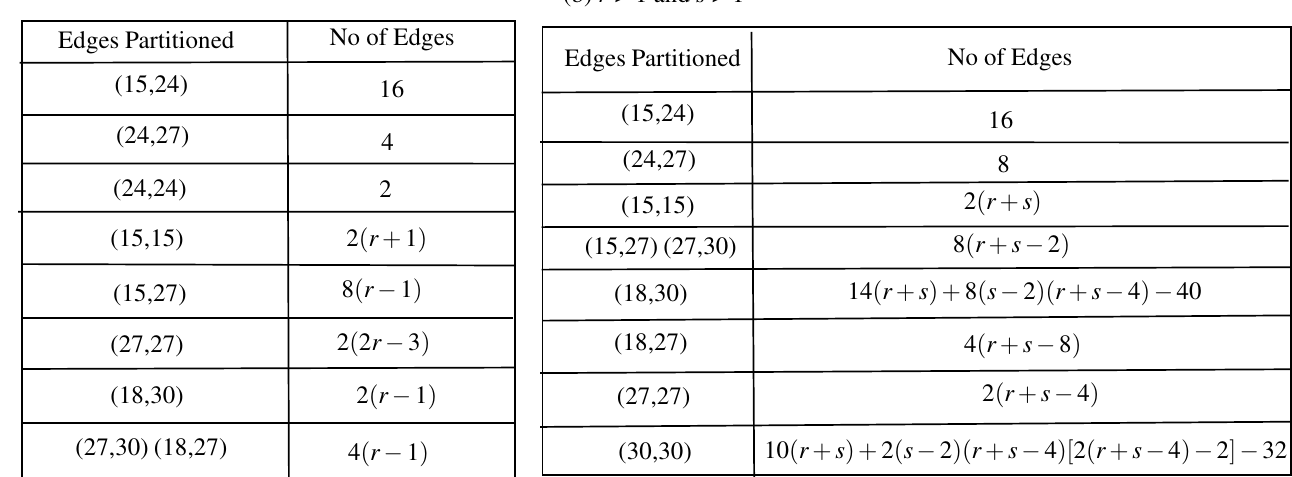
Table 6: Semi-total(line) graph of Nanotorous for Neighborhood vertices (b) r > 1 and s >